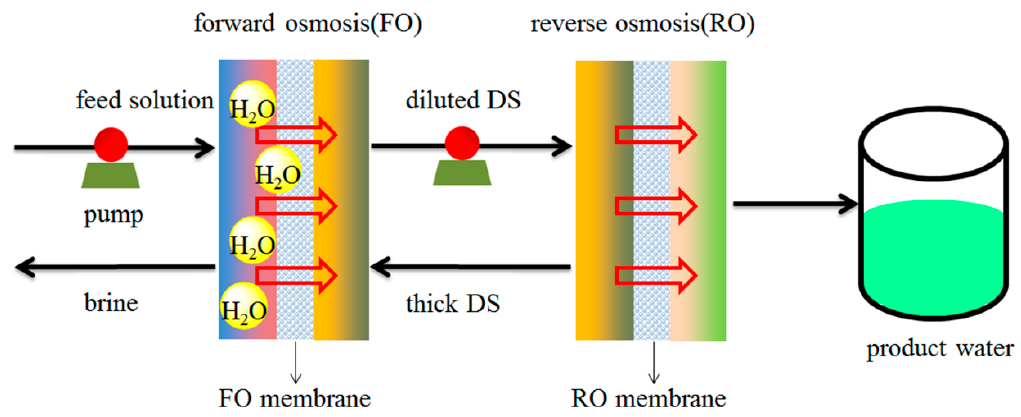
Figure 3. Schematic illustration of using a hybrid FO ‐ RO process for desalination seawater.